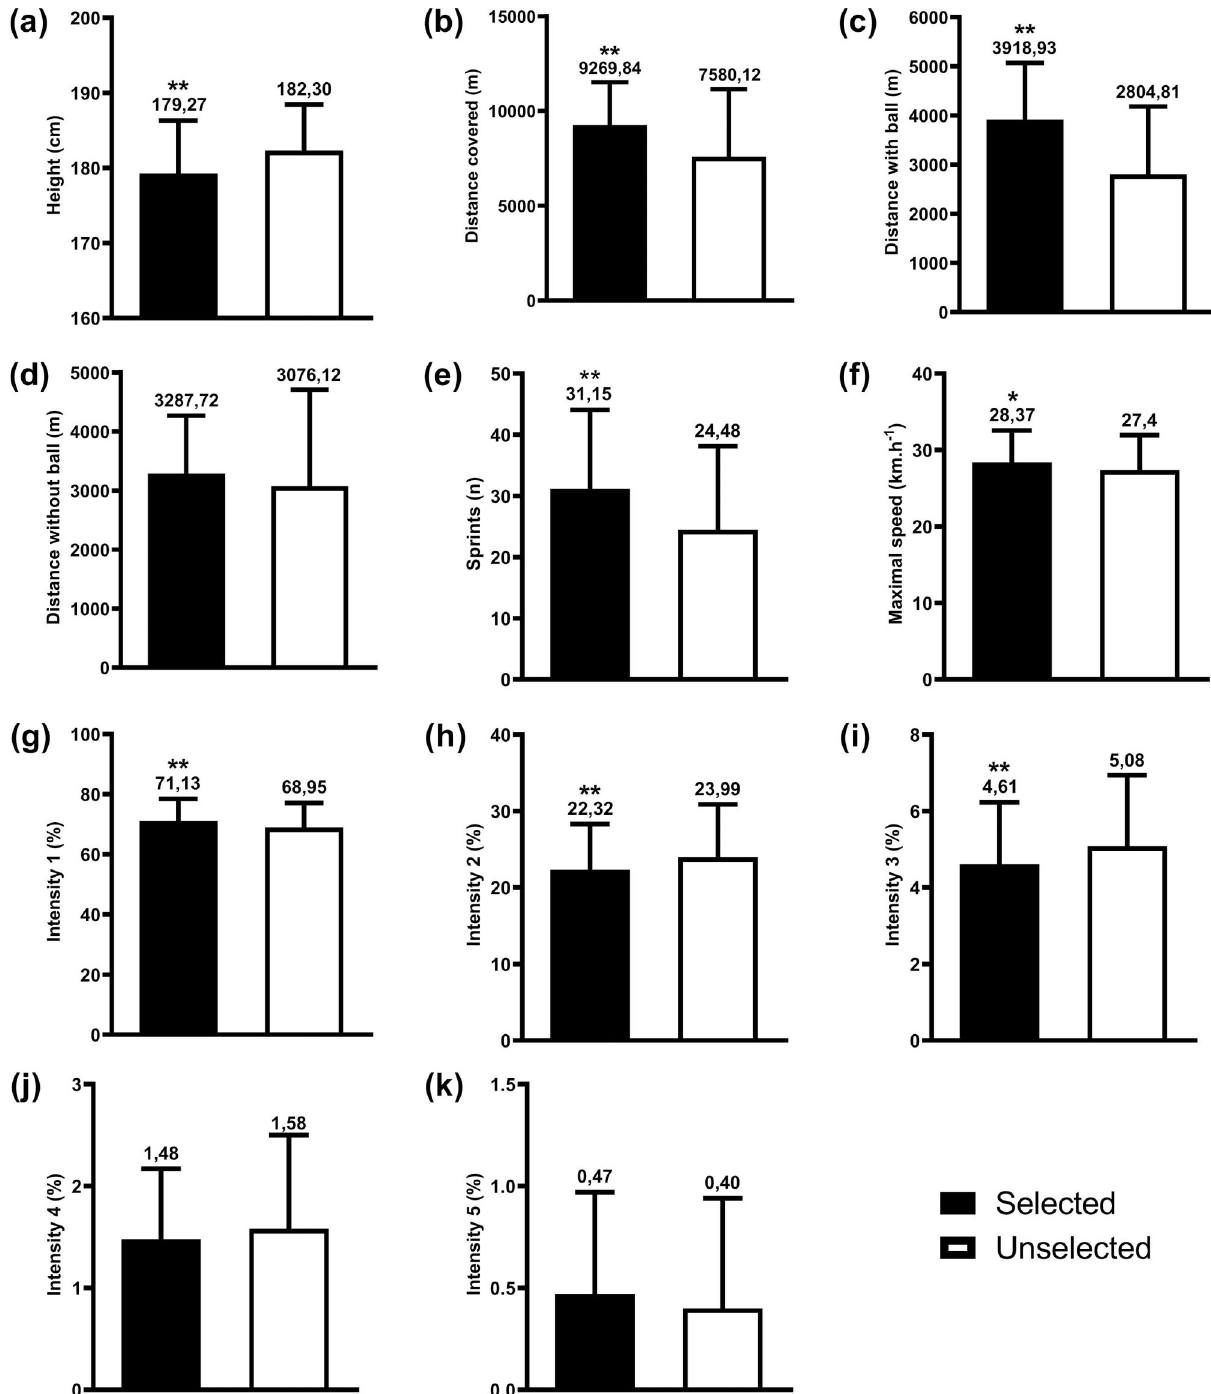
Figure 3 - Physical variables of soccer players. Black bars: selected players. White bars: unselected players. ∗ statistically significant difference (p < 0.05); ∗∗ statistically significant difference (p <